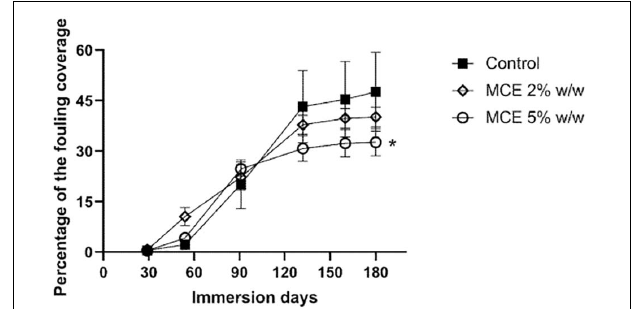
FIGURE 7 | Average percentage fouling coverage on panels coated with a control solvent-based self-polishing coating ( n = 12, black squares) and with the methanol cell extract (MCE) of B. licheniformis at 2% (open rhombus) and 5% (open circles) w/w ( n = 3) submerged in the Red Sea for 180 days (June–December 2016). Error bars represent standard deviations of the mean. * indicates statistical significance between a treatment and the control group (linear mixed-effects model with nested random effects, Bonferroni correction, Tukey post hoc analysis, p <